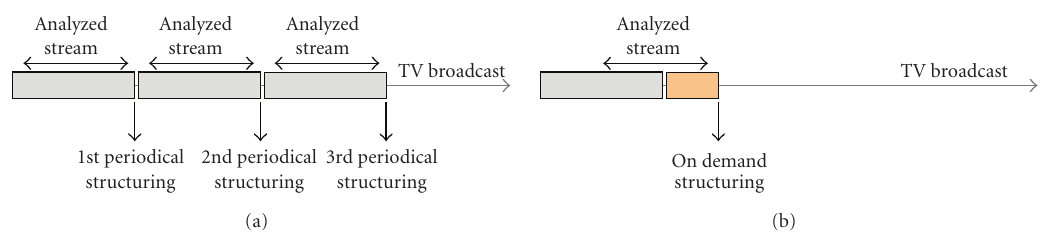
Figure 2: Processing scheme of the TV broadcast by DealTV. (a) Periodical structuring. (b) On demand structuring.